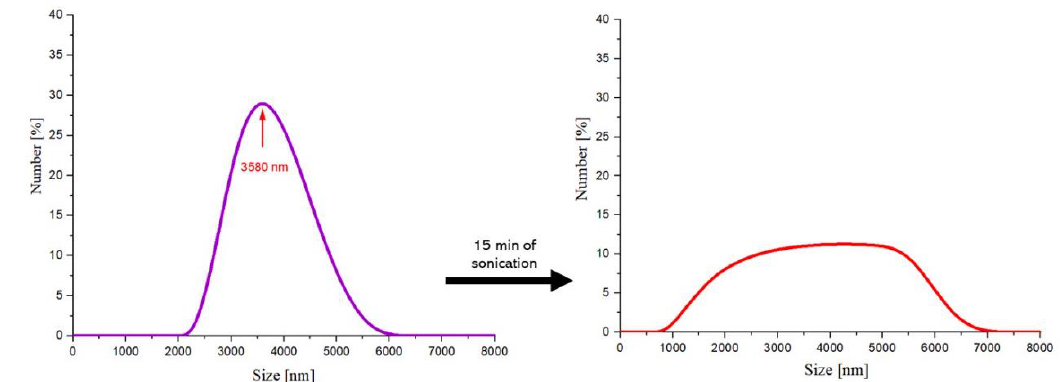
Figure 3. DLS (Dynamic Light Scattering) measurements of the Fe 3 O 4 particles directly after the synthesis (left) and after 15 min of sonication (right).